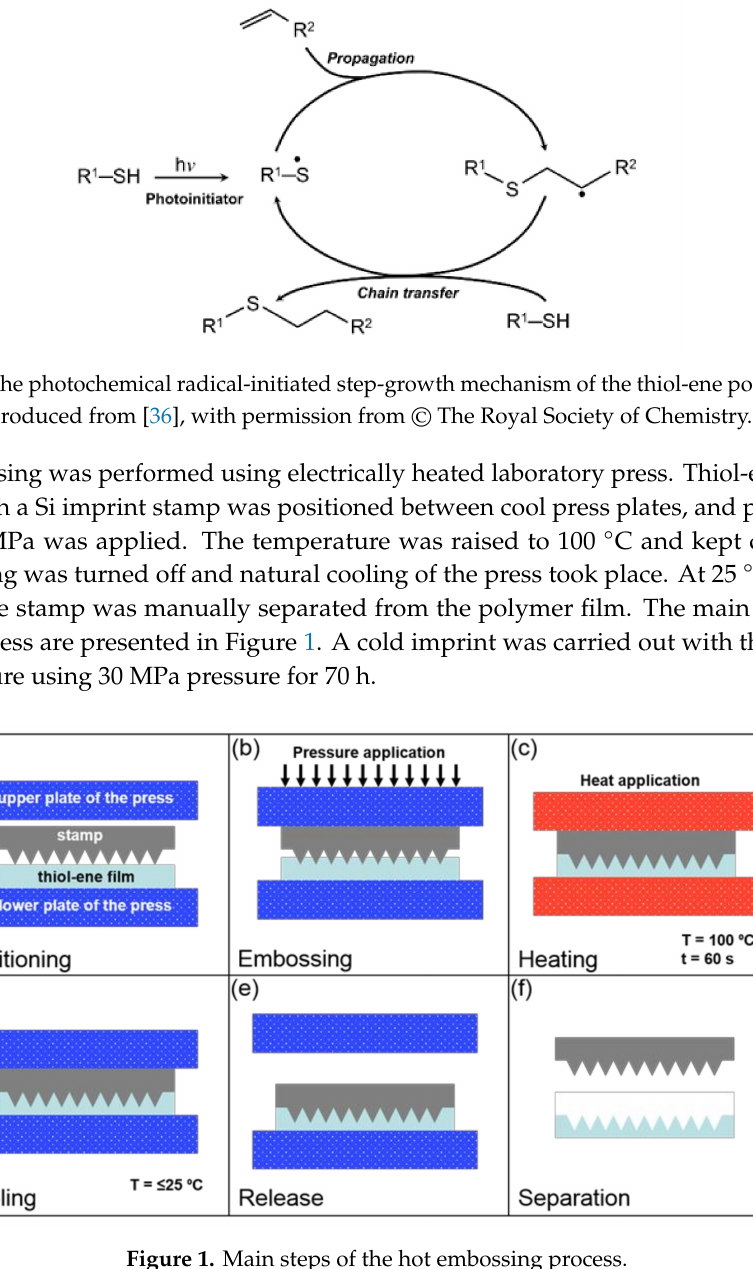
Figure 1. Main steps of the hot embossing